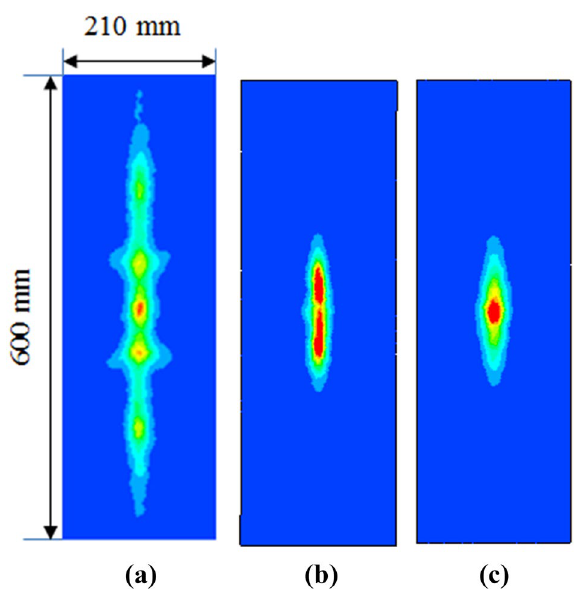
Fig. 11 Coating film thickness distribution contours: a three-noz- zle; b double-nozzle; c single-nozzle [21,